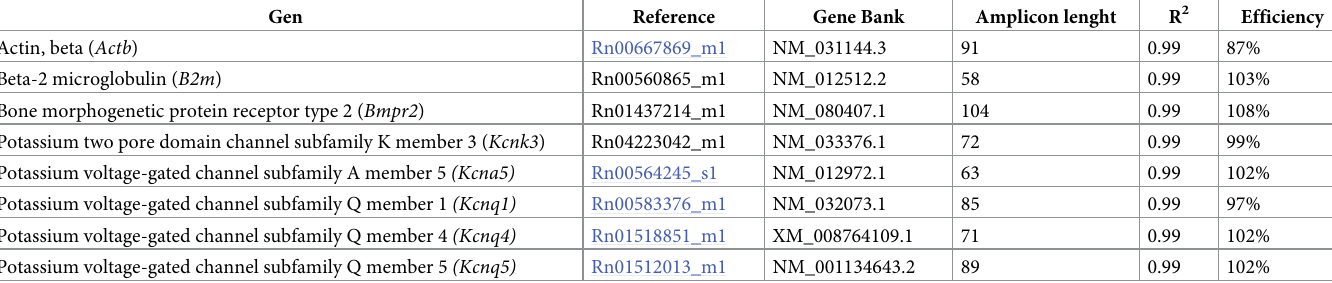
Table 1. Taqman primers used in this study (all from Applied Biosystems).